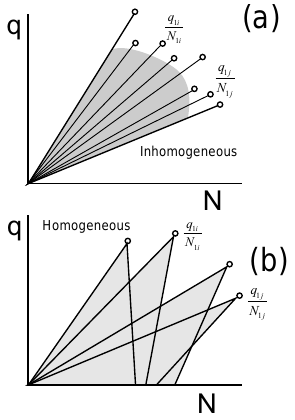
Figure 12. Conceptual diagrams of scattering of measurements of q vs. N for (a) extreme inhomogeneous and (b) homogeneous mix-